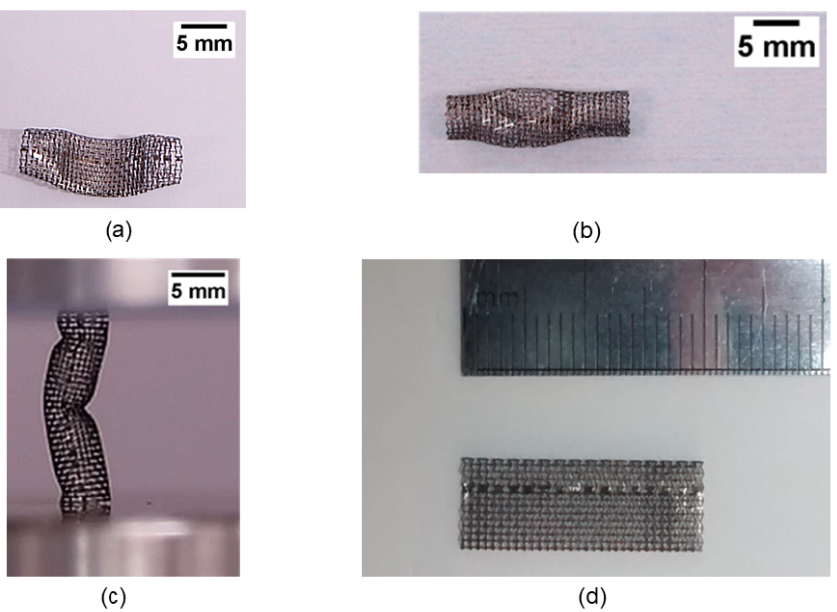
Figure 6. Failed stent samples under: ( a ) three-point bending; ( b ) torsion; ( c ) longitudinal compres- sion; and ( d ) lateral